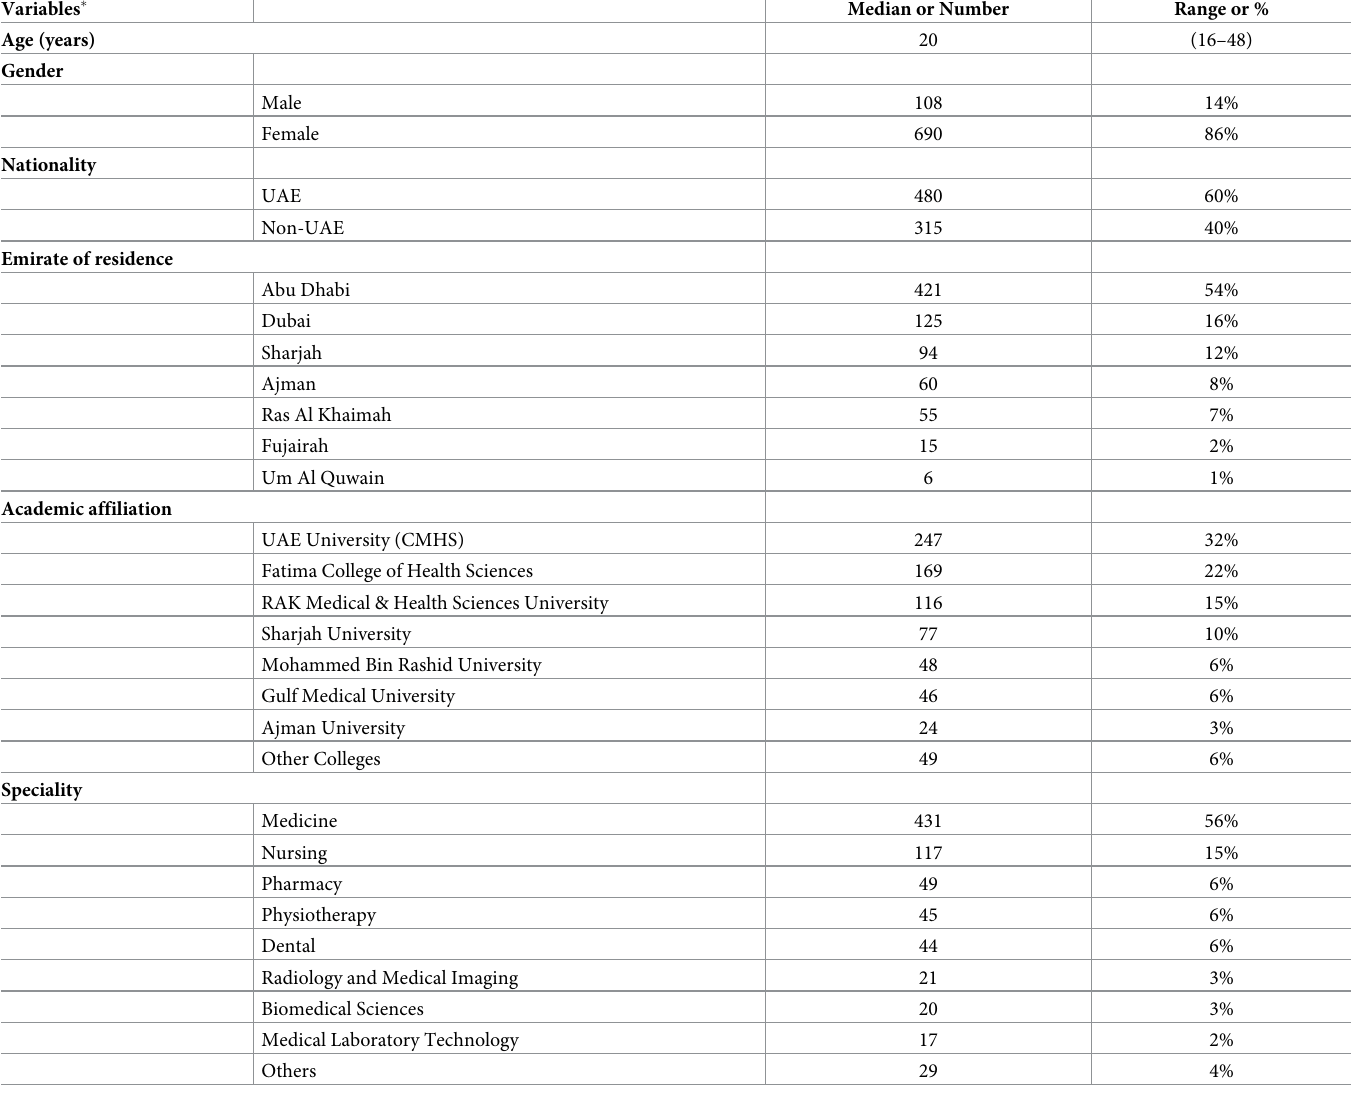
Table 1. Characteristics of respondents of the KAP survey collected between 2nd June and 19th August 2020. Variables